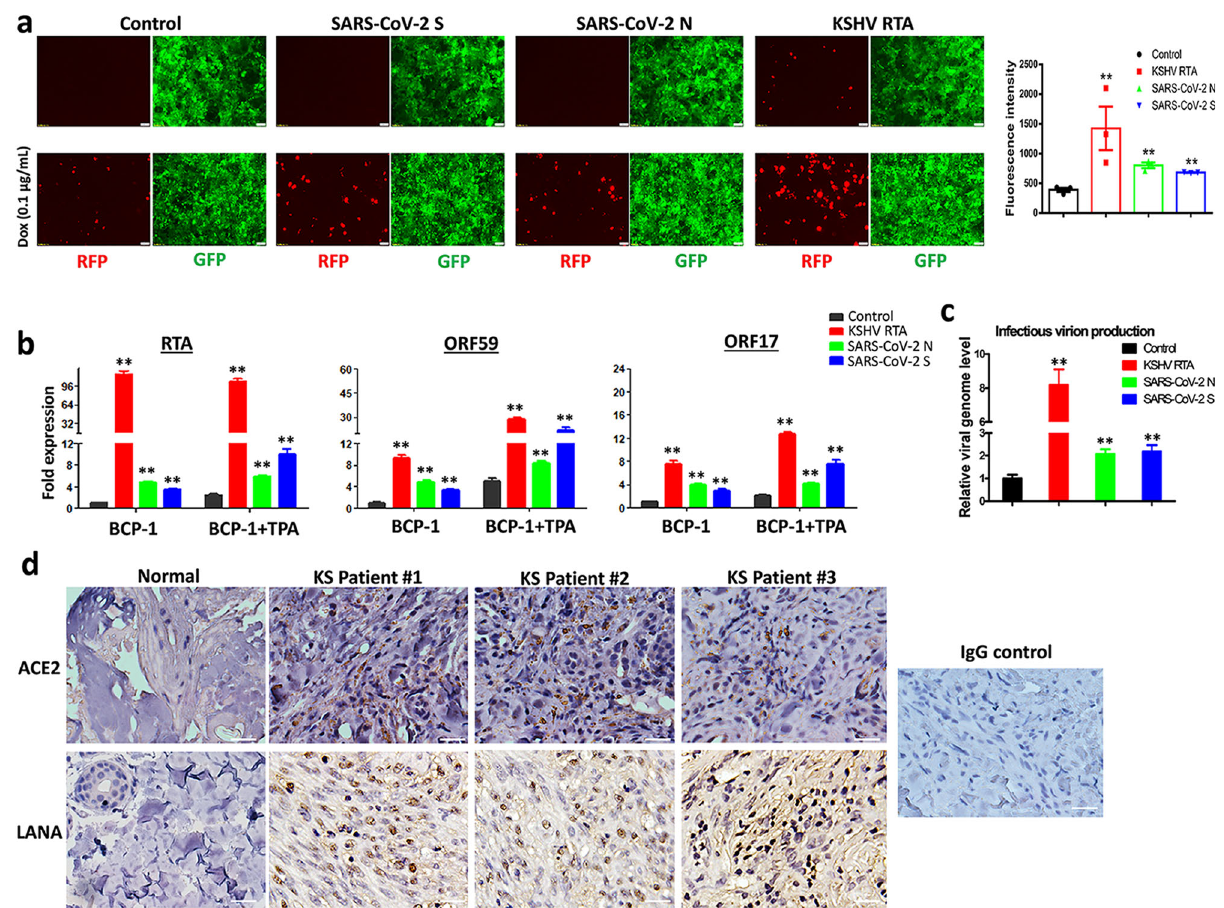
Fig. 1 Ectopic expression of SARS-CoV-2 proteins induces KSHV lytic gene expression and ACE2 expression is increased in AIDS-KS tissues. a The iSLK.219 cells were transfected with vector control or vectors encoding SARS-CoV-2 spike protein (S), nucleocapsid protein (N) and KSHV RTA (as a positive control) with or without low dose of doxycycline (Dox, 0.1 µ g/mL) induction for 72 h. The expression of RFP (representing viral lytic reactivation) and GFP (representing infected cells) were detected using fl uorescence microscopy. Error bars represent S.D. for 4 image fi elds per well. b , c BCP-1 cells were transfected as above with or without low dose of 12- O -tetradecanoyl-phorbol-13-acetate (TPA, 1.0 ng/mL) induction for 72 h, then the transcripts of representative lytic genes were quanti fi ed by using qRT-PCR. The supernatants from transfected cells were collected to infect naive HEK293T cells, then viral genome levels were quanti fi ed by using qPCR with Lana -speci fi c primers. Error bars represent S.D. for 3 independent experiments, ** p < 0.01 (vs the vector control). d Expression of ACE2 and LANA (as well as representative IgG control) in formalin- fi xed paraf fi n-embedded KS tissues from 3 HIV + patients and normal skin tissues were determined by immunohistochemical staining as described in the “ Methods ” . Bars: 50 μ